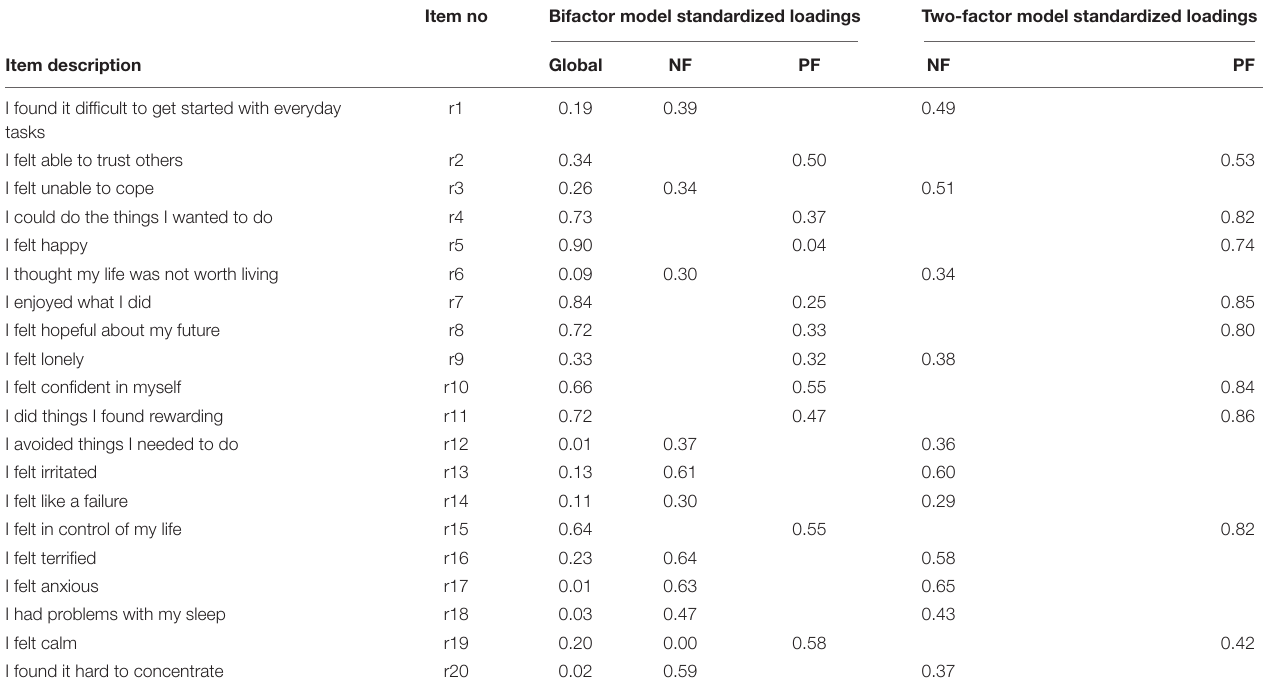
TABLE 3 | Results of CFA for the